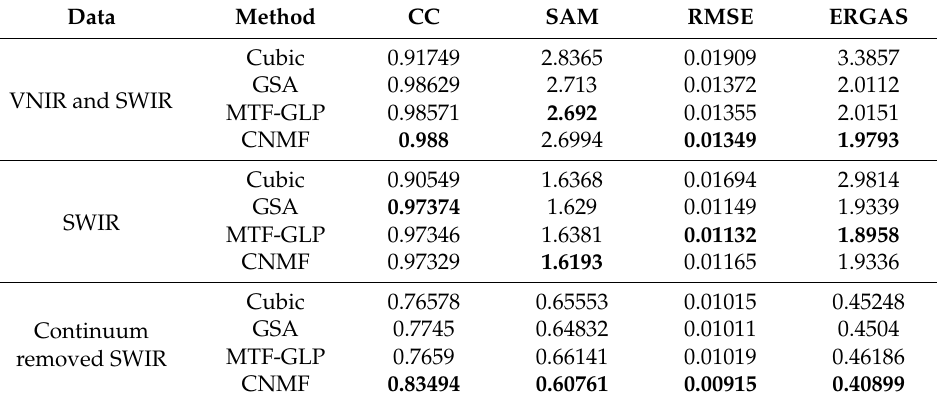
Table 2. Quality